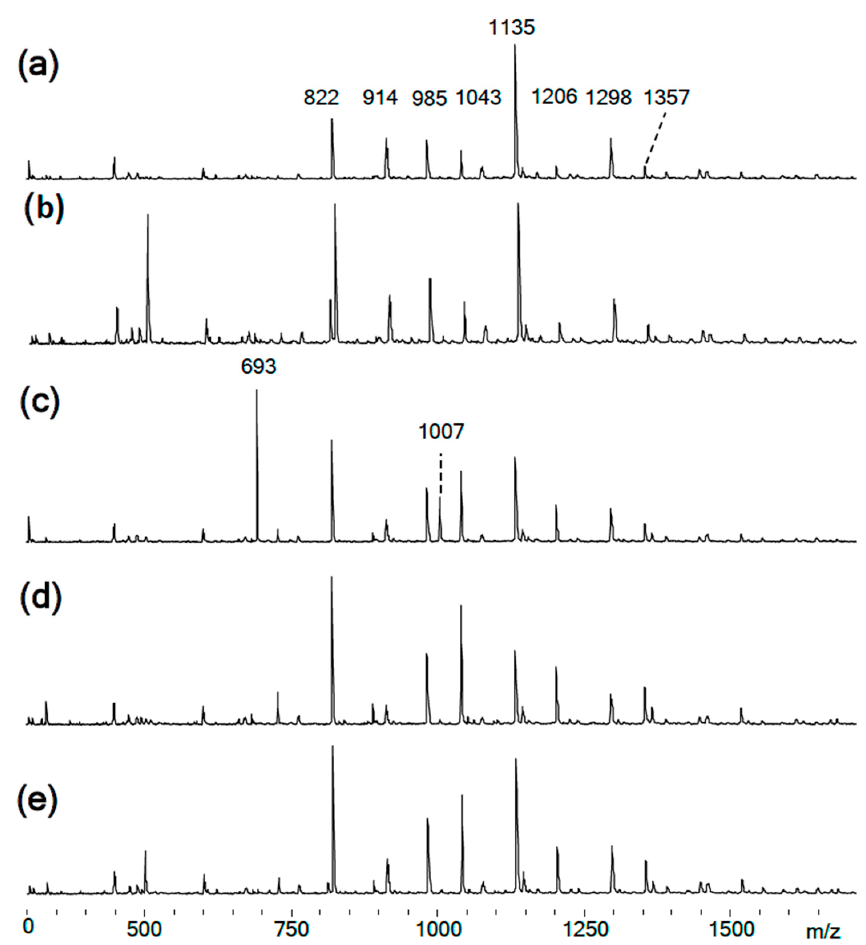
Figure 4. ( a–e ) MALDI-TOF spectra of the obtained PhER syntheses of PNA-BPF-1 ÷ 5, respectively.